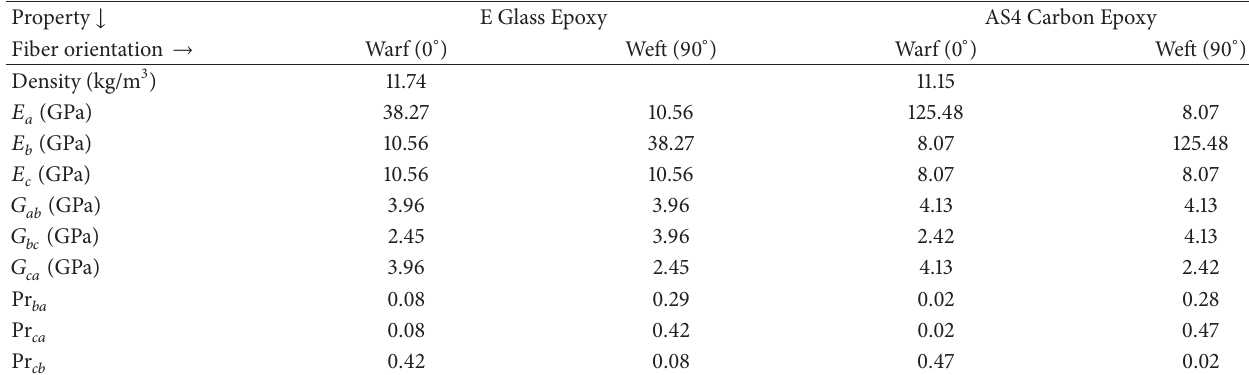
Table 2: Unit cell